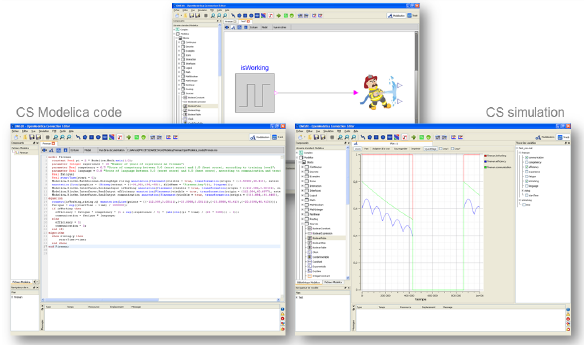
Figure 9. CS behaviour modelled in other tools (e.g. OpenModelica)